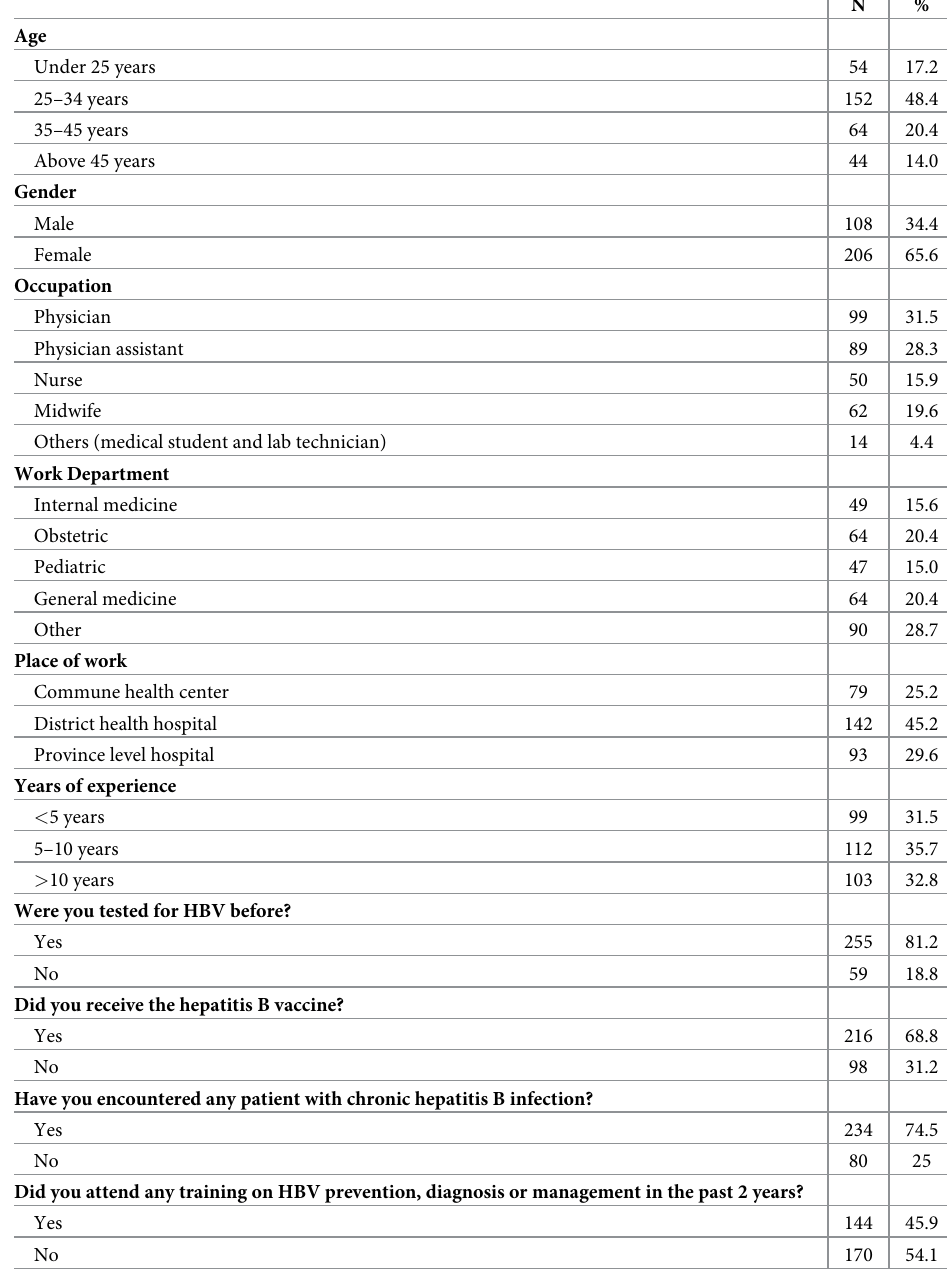
Table 1. Distribution of demographic factors and HBV related experience (N = 314).